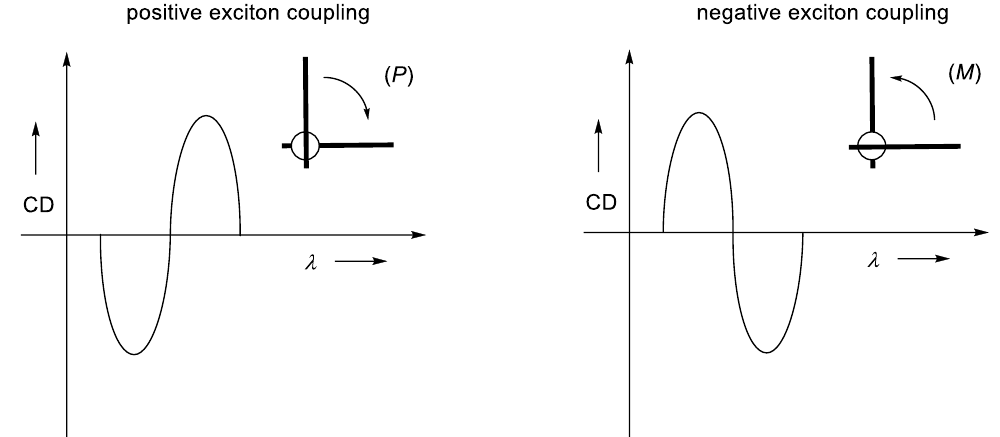
Scheme 2. Representation of the bisignated CD signal arising from the interaction between two independent chromophores with a relative positive ( left ) or negative ( right ) twist.